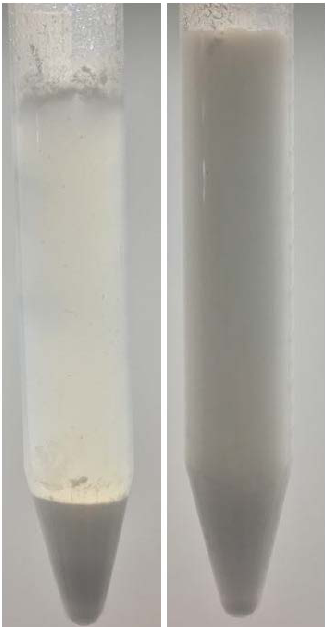
Figure 6. Powders i (left) and d ( right ) redispersed after spray